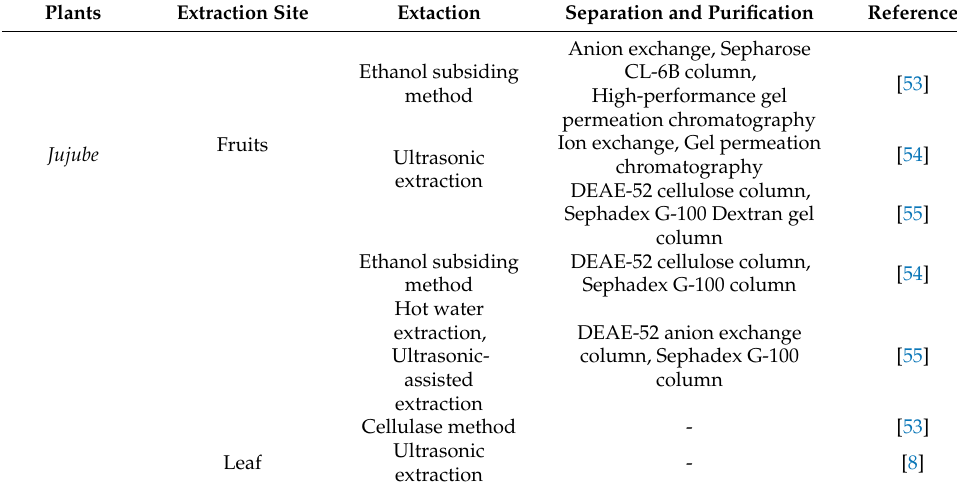
Table 3. Cont . Plants Extraction Site Extaction Separation and